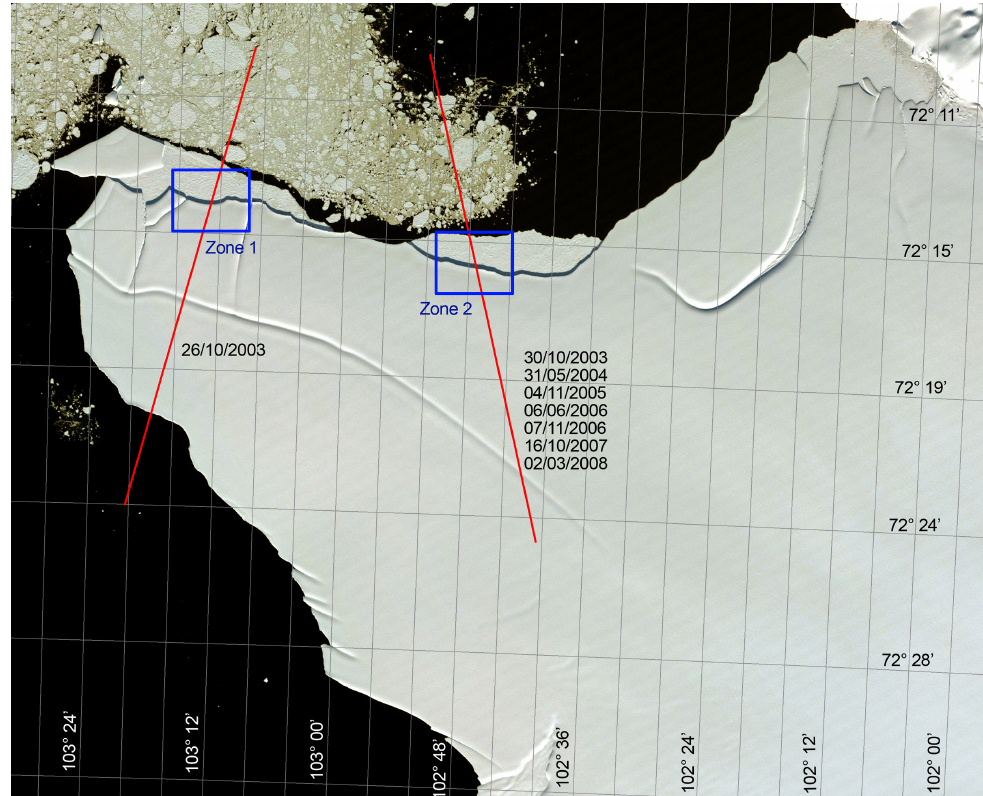
Figure 14. ASTER L1A scene from 4 January 2005, used for the Abbot ice shelf validation site. ICESat ground tracks are shown in red, together with the dates of the available profiles on each track. Validation measurements were carried out on each ground track using shadows projected over the sea ice, in the areas designated as Zone 1 and Zone 2 (blue boxes).